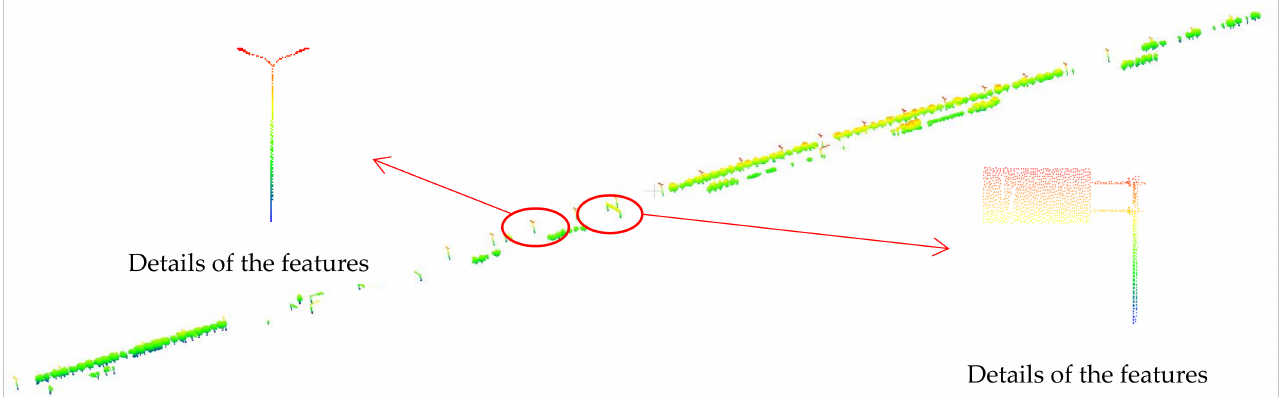
Figure 7. Pole-like object point cloud after